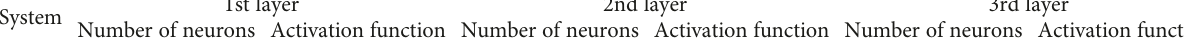
Table 5: Structures of the proposed ANN controllers.